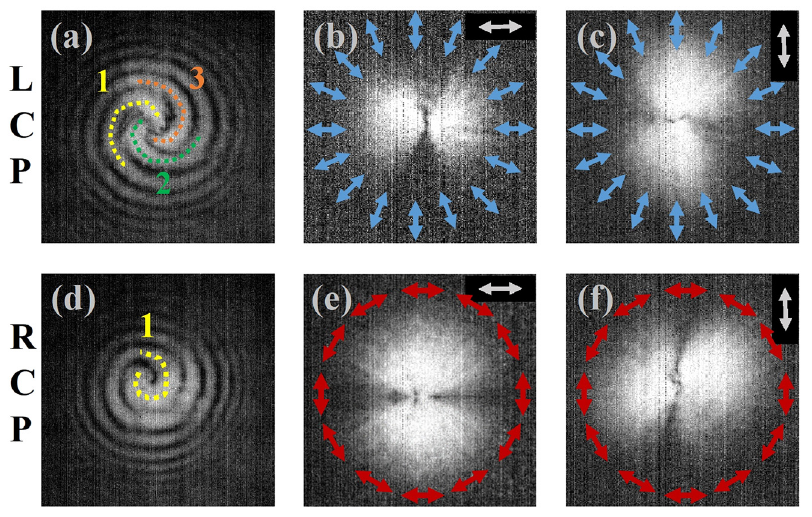
polarization patterns at